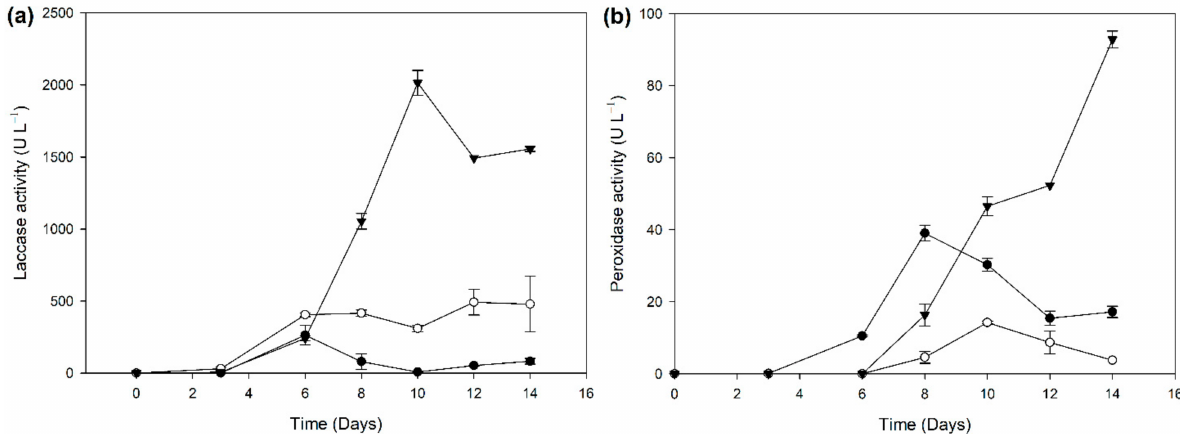
Figure 4. Laccase activity ( a ) and peroxidase activity ( b ) during the growth of P. citrinopileatus ( black circles ), A. biennis ( white circles ) and G. resinaceum ( black inverted triangles ), on